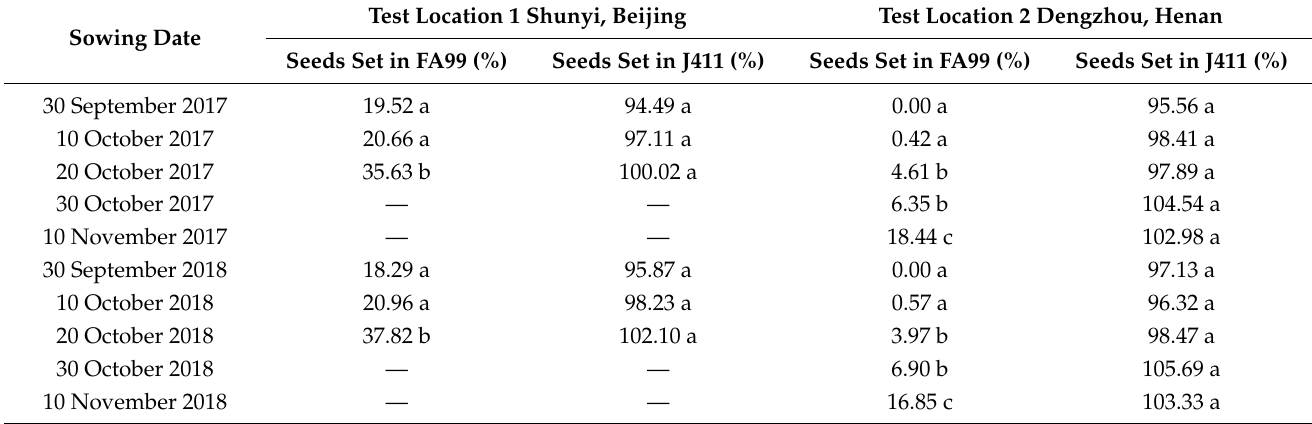
Table 1. Seed setting rates of FA99 and J411 in Shunyi, Beijing and Dengzhou, Henan during 2017 and